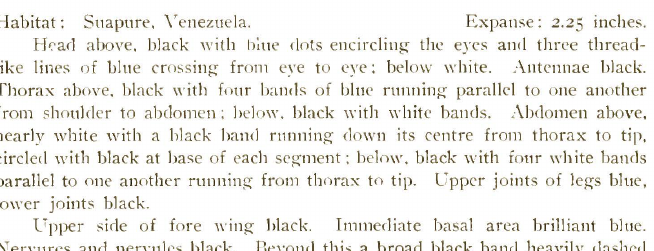
next lower interspaces. The entire inner marginal area is dusted with golden scales and hairs. The hind margins of both wings have a dark thread and a fringe of tawny, darker on fore wing than on hind wing. Under side of fore wing bright tawny. The tawny markings of upper surface show in a somewhat lighter shade. The basal area below costa is nearly black and below it the inner marginal area is mouse color. Hind margin edged with a dark brown thread. Fringe slightly darker than ground color. Under side of hind wing very bright tawny approaching a golden yellow. The tawny markings of upper surface are barely noticeable. Towardli anal angle, the ground color darkens in a slight degree. Hincl margin edged with a dark brown thread. Fringe slightly darker than ground color. Taken in November and December.